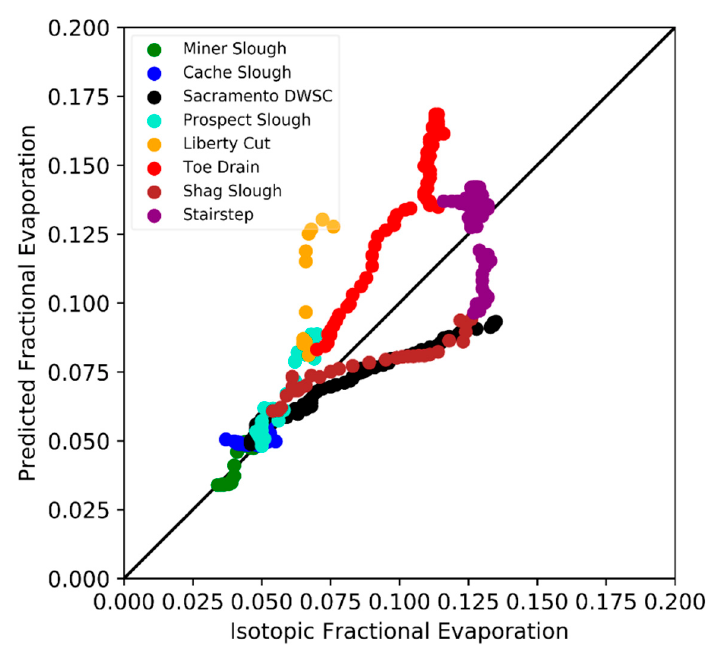
Figure 10. Relationship between predicted and isotopic fractional evaporation at the time and location of continuous underway measurements.